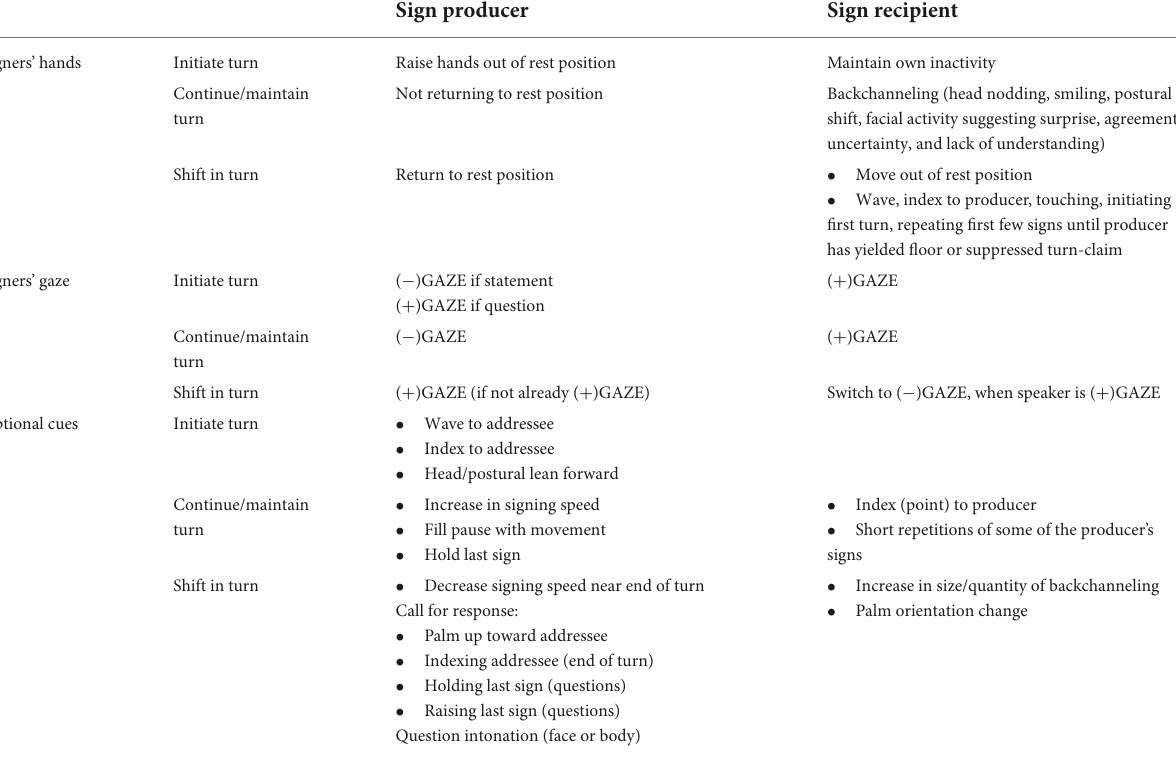
TABLE 2 Turn cues from American Sign Language (ASL) identified in Baker